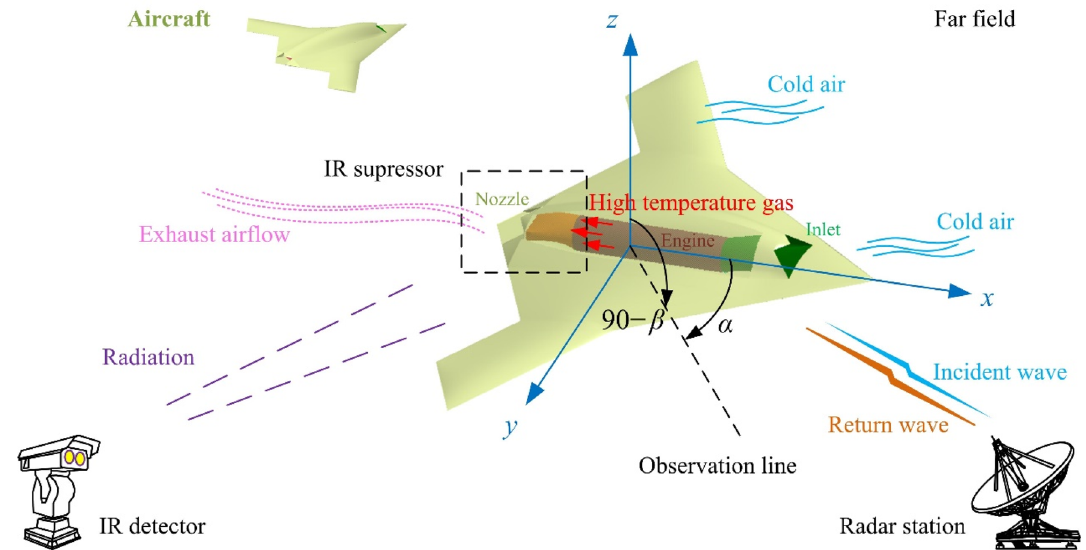
Figure 1. Schematic diagram of radar/infrared integrated stealth design of aircraft exhaust system, drawn using Microsoft Visio